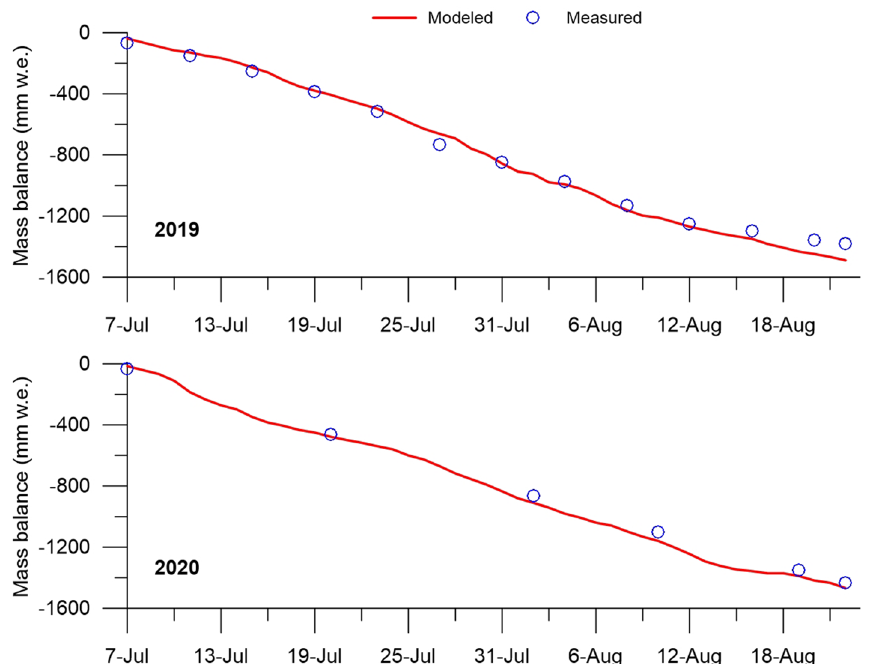
Figure 6. Modeled and measured glacier mass balance (mm in w.e.) for the period from 7 July to 23 August 2019–2020. To minimize the measurement errors, the measured ablation in 2019 was taken as 5-day